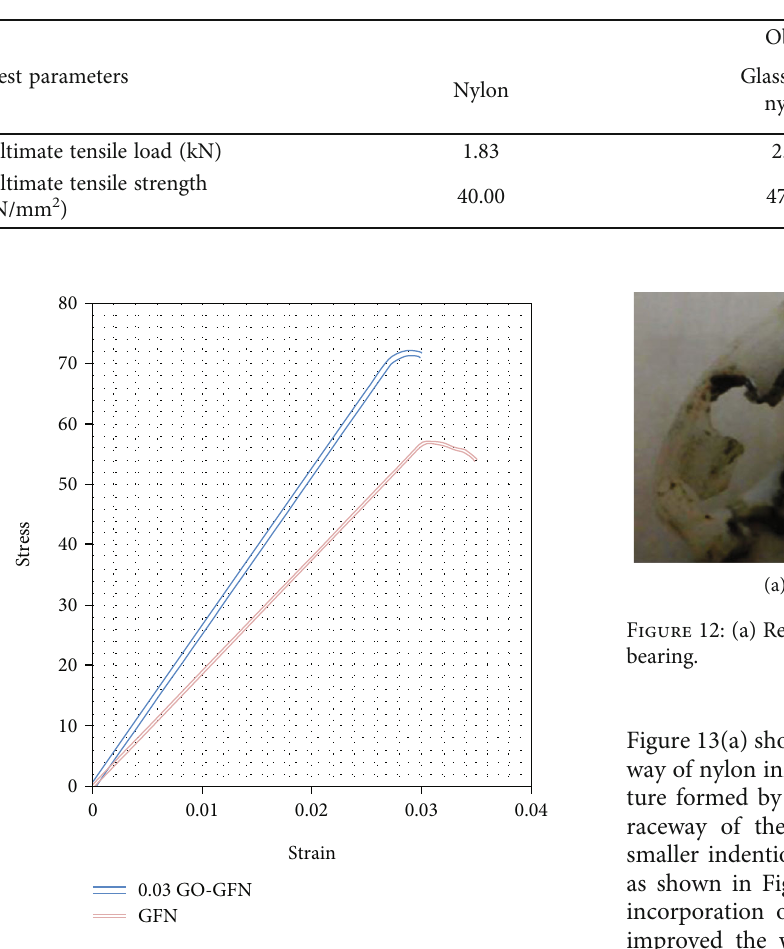
Figure 11: Stress – strain curve for GO-GFN hybrid nanopolymer.